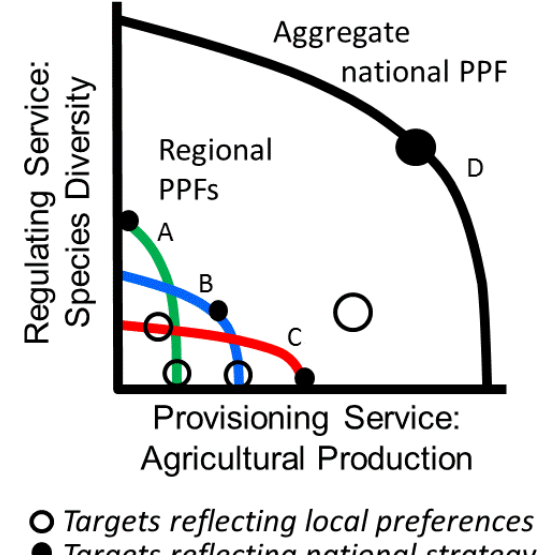
Fig. 3 . A stylized representation of challenging situation 4, spatial and scale-dependent variation in production possibility frontiers (PPFs), as illustrated with an example from Mexico (see text). Trade-offs between agricultural productivity and biodiversity maintenance are considered at local scales in three ecological regions in Mexico and at the broader national scale. Curves A, B, and C represent region-specific PPFs for the trade-off, and the black curve (D) represents the national PPF, aggregated over the included regions. Region A represents an area with low agricultural potential but high species richness, region C represents an area with high agricultural potential but low species diversity, and region B is intermediate. Small closed circles indicate local targets for achievement of a national land- sparing strategy to maximize both biodiversity and agricultural output at the national level. Small open circles represent local targets according to local values within each region. The large closed circle represents the national-level service rendering under “land sparing,” which is optimally efficient at the aggregate, national level. The large open circle represents the national-level services that would be rendered if each region were managed according to local priorities, which are not optimal by national standards but maximize utility for stakeholders in each region. (See Appendix 1 for details regarding the assumptions and calculations used to the derive